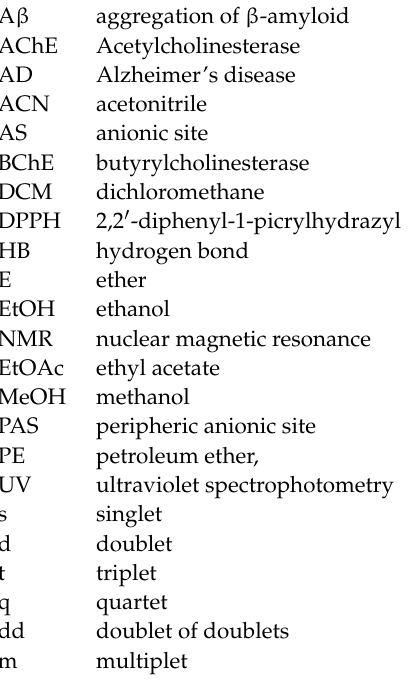
Tables S1–S4: Data for molecular docking; Tables S5 and S6: Crystal data. Table S7: Geometric parameters of π interactions in the compound trans-6.